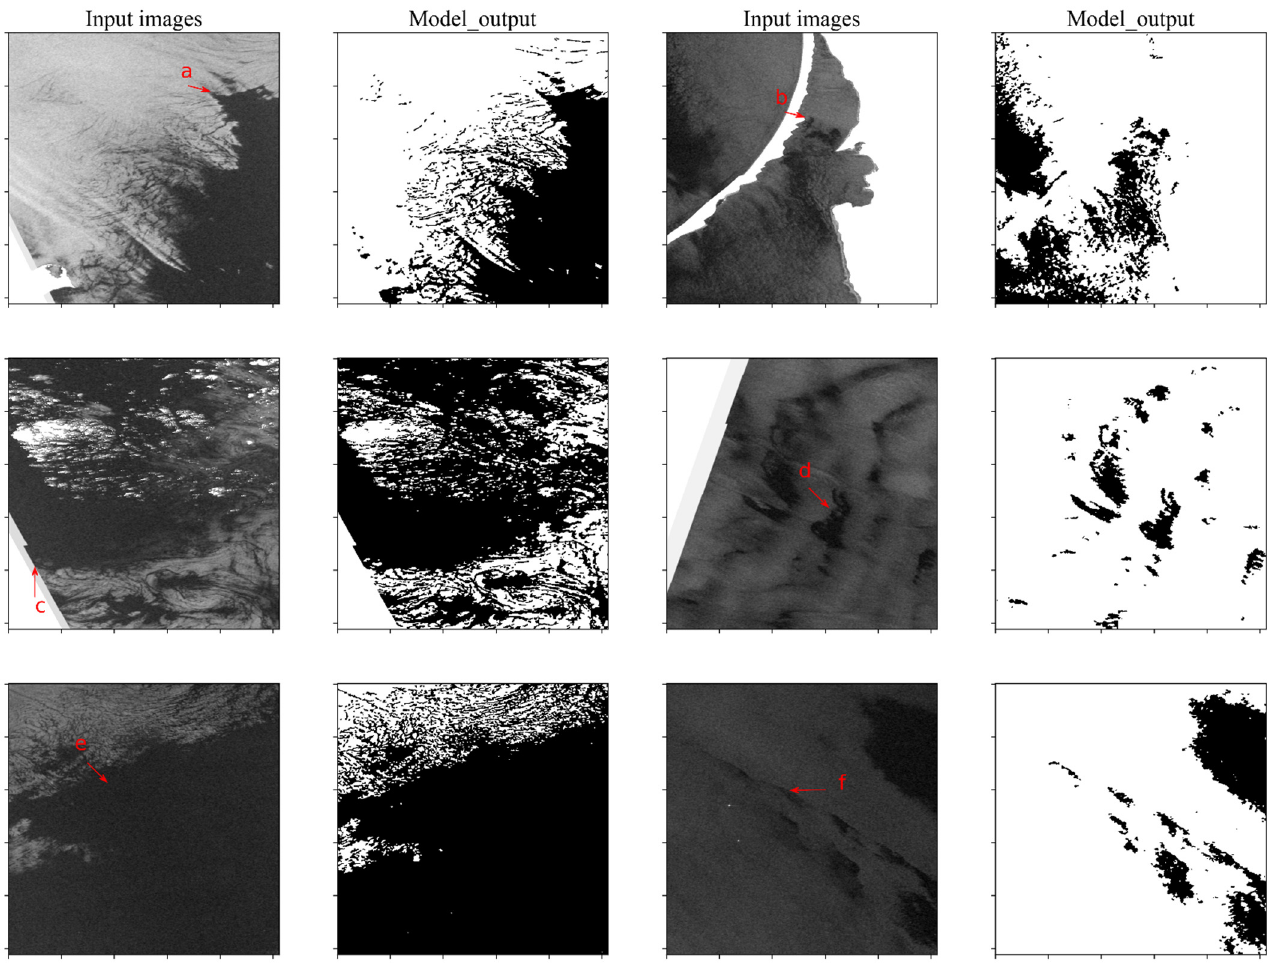
Figure 8. The segmentation results of various lookalikes; the a~f arrows point to the dark spots. Table 5. Ocean and atmospheric characteristics of the lookalikes in Figure